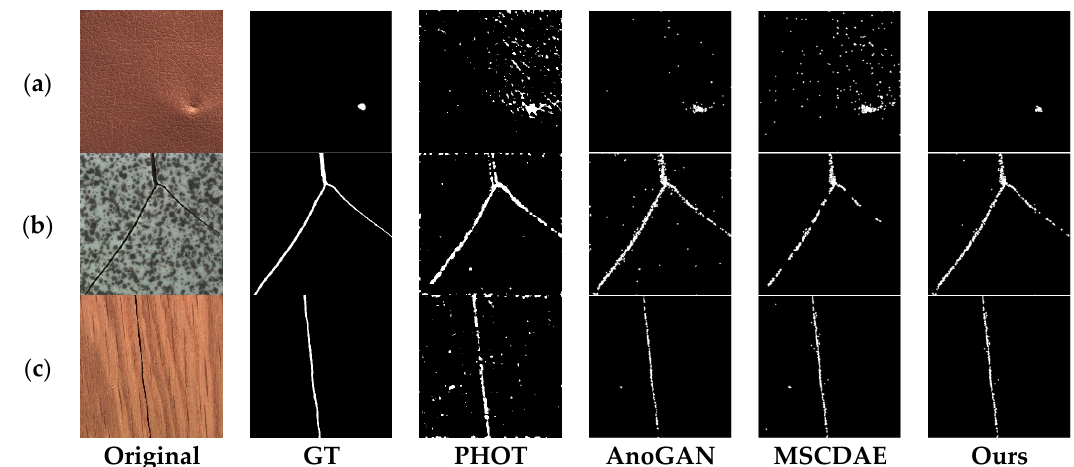
Figure 8. Segmentation results of defective samples with three kinds of textural background from Patterned Fabric dataset under different methods. Each row from left to right are original defect image, ground truth image, results derived from PHOT, AnoGAN, MSCDAE, and our methods. ( a ) box; ( b ) dot; ( c ) star.